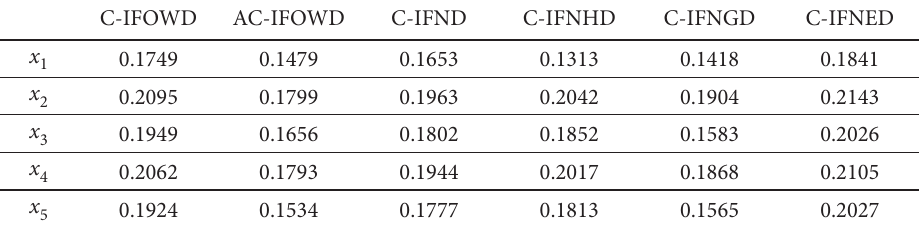
Table 10. Aggregation results